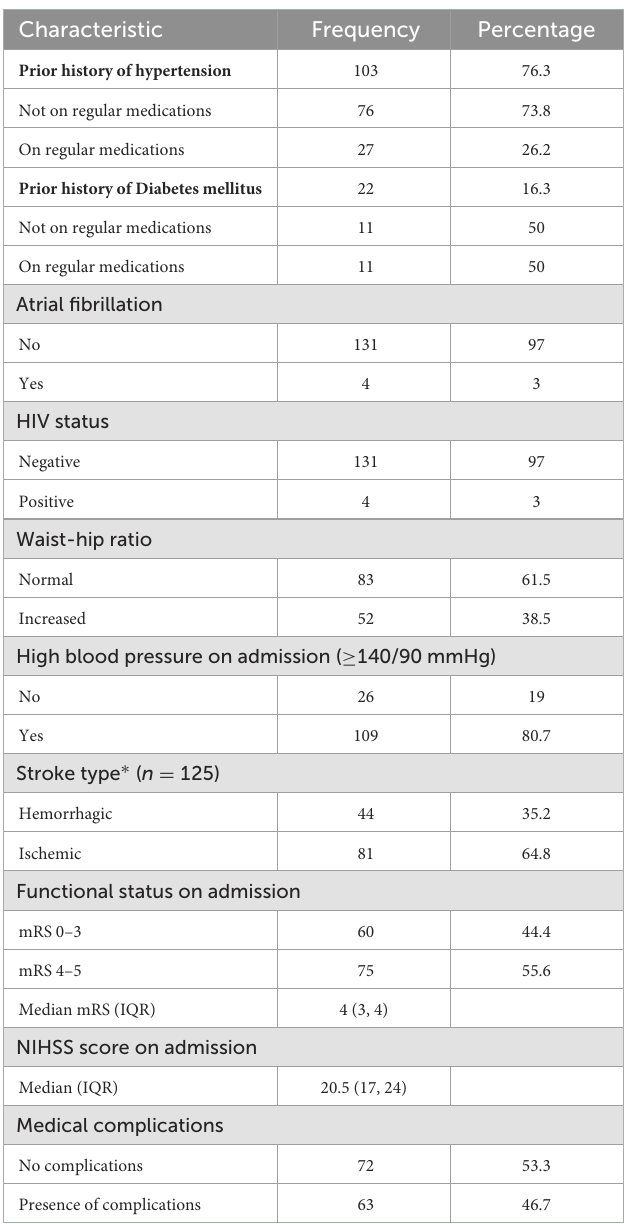
TABLE 2 Clinical characteristics of the study